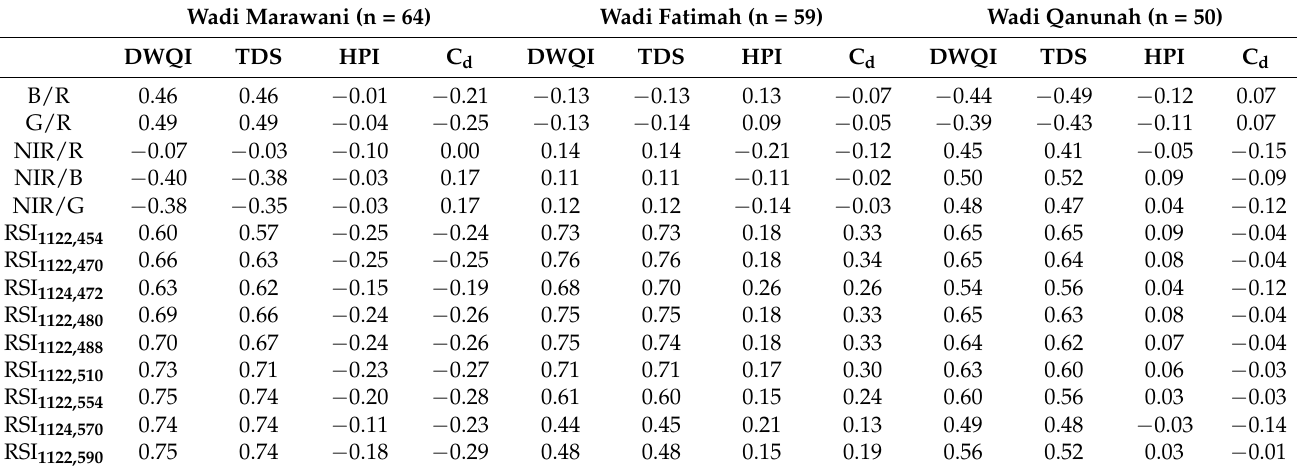
Table 8. Correlation coefficient of the linear association between SRIs and DWQI, TDS, HPI, and C d . Wadi Marawani (n =